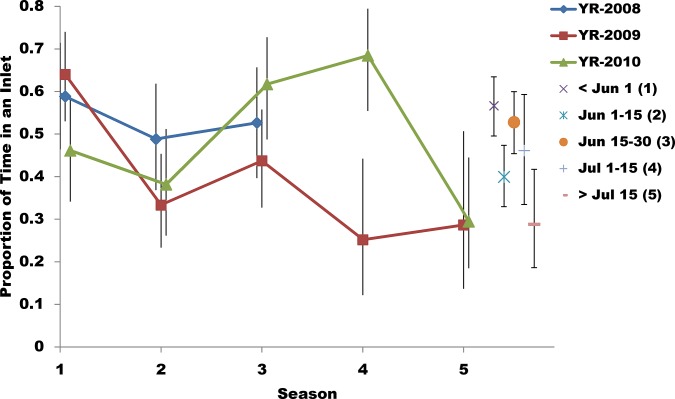
Proportion of time that radio-tagged harbor seals spent in glacial habitat.Proportion of time seals (n = 104; tagged in Endicott Arm) spent in Tracy or Endicott Arms by year and season. Vertical bars are 95% Confidence Intervals, by year, season, and location (on left), and (on right) by season (all years combined). Season numbers and their respective range of dates are in the legend.